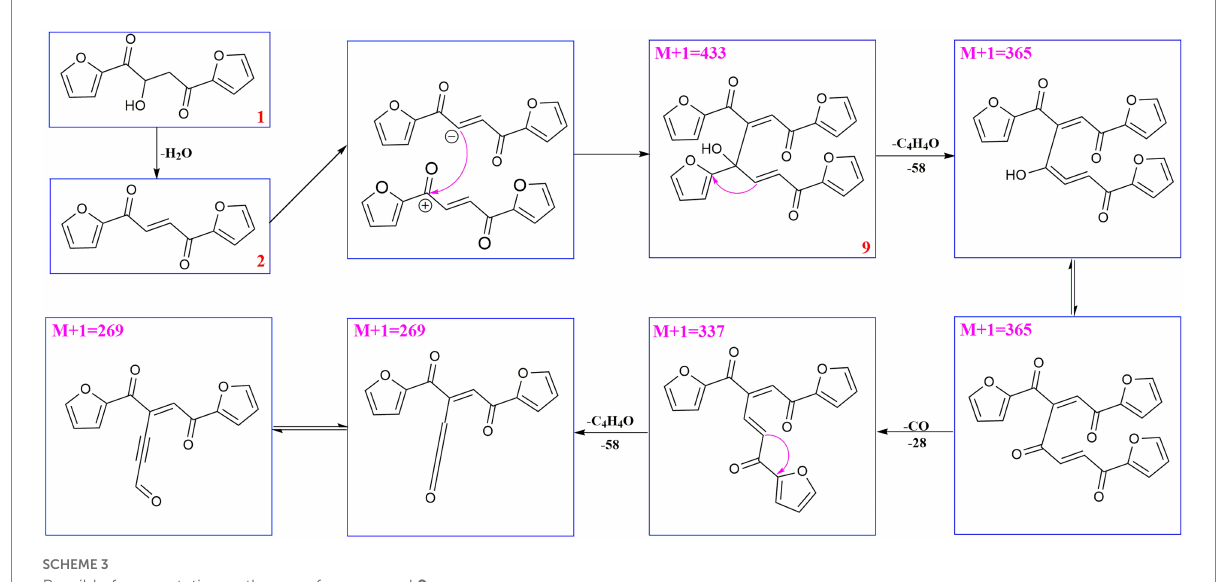
SCHEME 3 Possible fragmentation pathways of compound 9